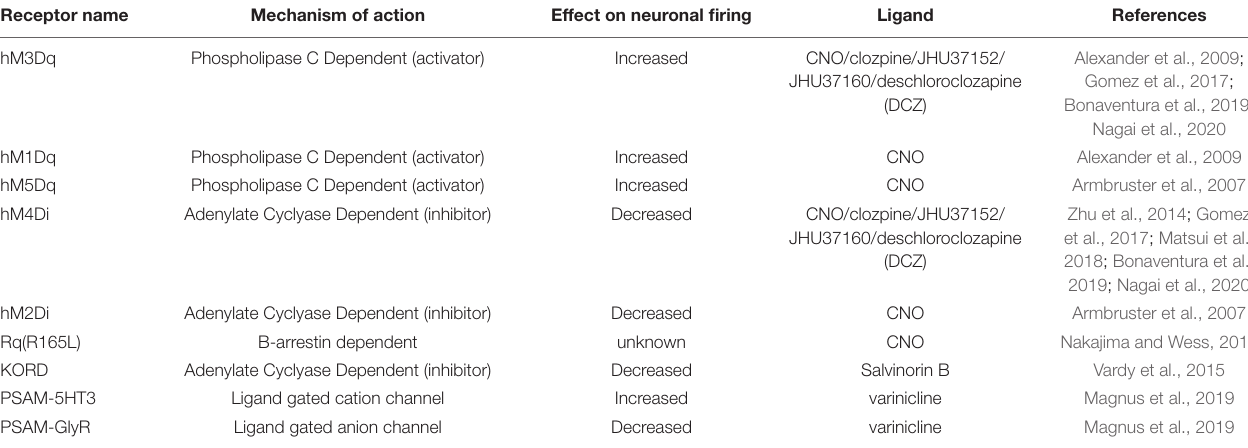
TABLE 8 | Common chemogenetic receptors and ligands with their associated properties and effects on neuronal